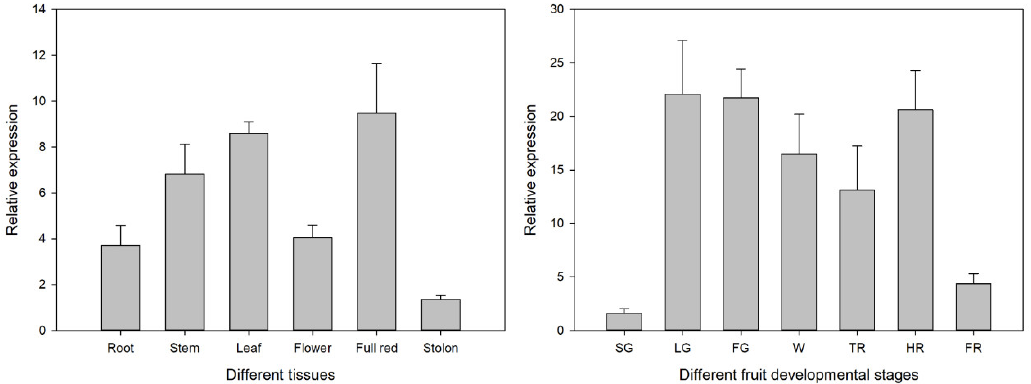
Figure 3. Expression level of FvSnRK1.1 in different tissues and during the fruit development. SG, small green; LG, large green; FG, fade green; W, white; TR, turning red; HR, half red; FR, full red.